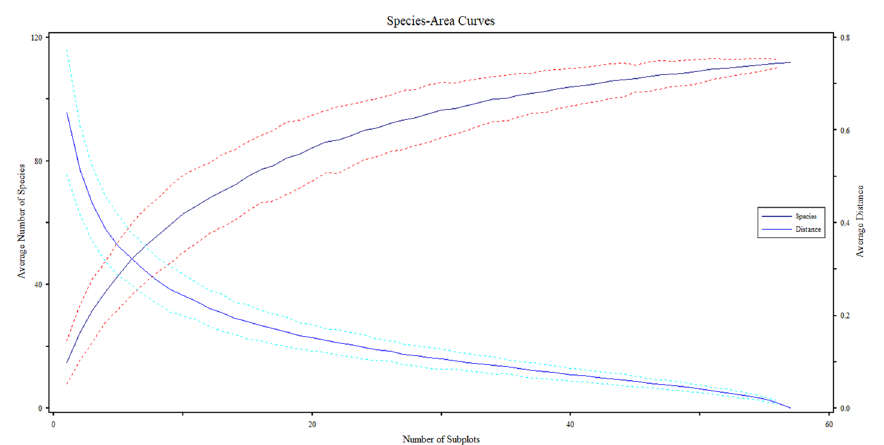
Figure 4. Species area curves representing relationship between occurring of new plant species along the sampling quadrats through compositional area